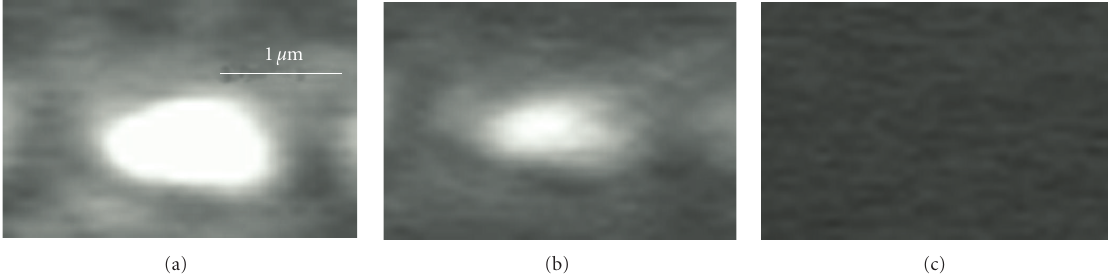
Figure 3: Images from the near infrared camera show the output of the DLSPPW waveguides at di ff erent polarizations of input light. (a) 0 ◦ Polarization (b) 45 ◦ Polarization (c) 90 ◦ Polarization. As can be seen, output intensity decreases drastically with